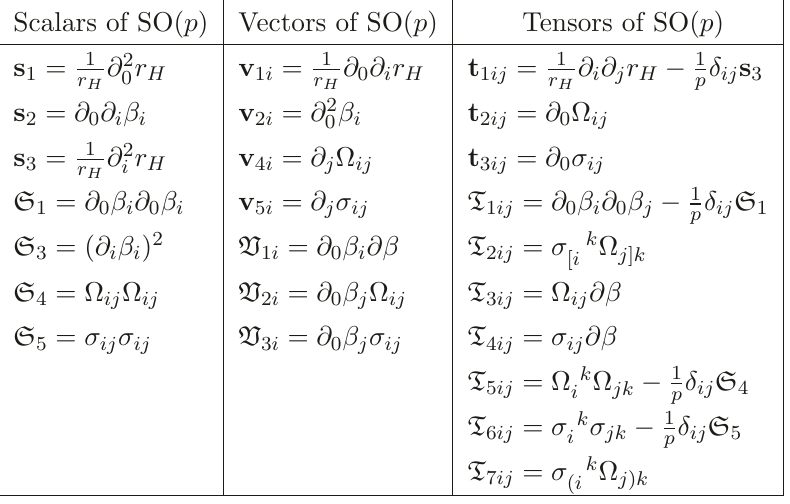
Table 1 . A list of second derivative order SO( p ) invariant viscous terms for p when p =